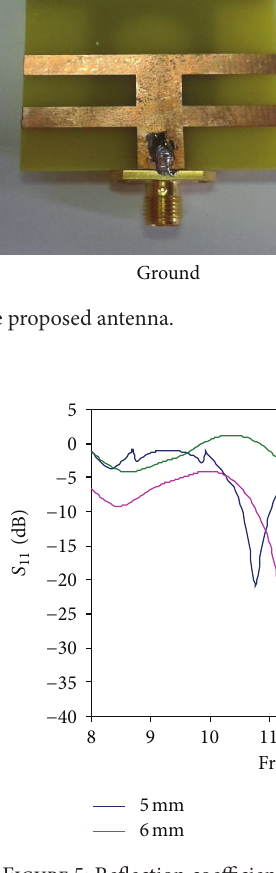
Figure 4: Comparisons of simulated return loss with different materials.